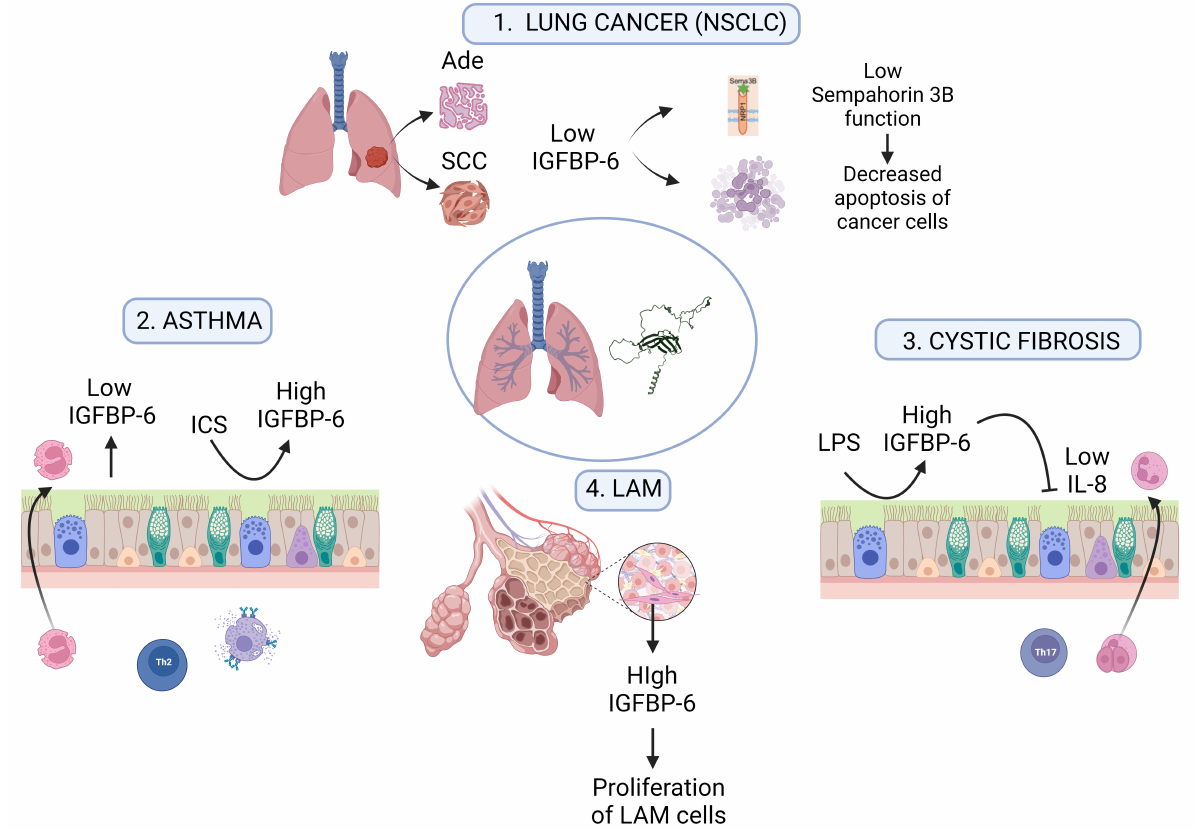
Figure 2. Roles of IGFBP-6 in respiratory diseases. (1) In NSCLC, adenocarcinoma (Ade), and squamous cell carcinoma (SCC) subtypes, IGFBP-6 expression is lower compared with healthy tissues, resulting in decreased function of Semaphorin 3B that in turn acts as a tumor suppressor gene by apoptosis induction. (2) Asthmatic airways, characterized by Th2 cell infiltration, eosinophil recruitment, and mast-cell activation, show low production of IGFBP-6 which is recovered by ICS (inhaled corticosteroid) treatment. (3) Cystic fibrosis airways display a Th17 dysregulation with heightened neutrophil recruitment. Bacterial lipopolysaccharide (LPS) upregulates IGFBP-6